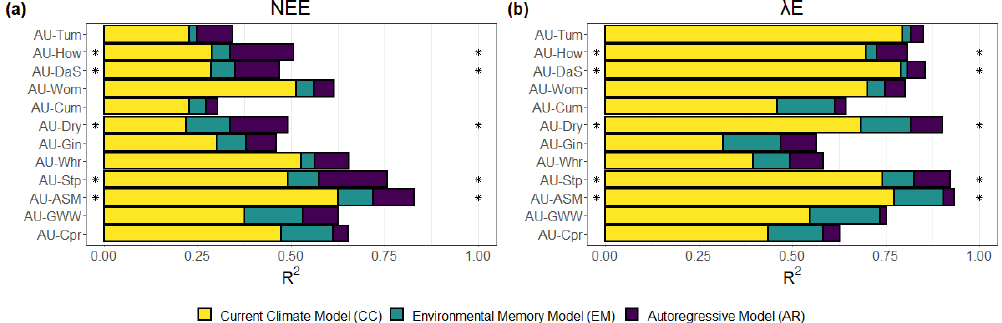
Figure 1. Model performance for (a) NEE and (b) λE . Sites are on the y axis, ordered by descending mean annual precipitation, with AU- Tum having the highest annual rainfall. The x axis is the cumulative coefficient of determination, R 2 . Yellow bars indicate the performance of the current-climate-only model (CC model), the turquoise bars are the improvement when memory effects were introduced with the SAM model (EM model), and the purple bar is the performance when the SAM residuals were further modelled with an AR1 process (AR model). Asterisks indicate sites belonging to the NATT.